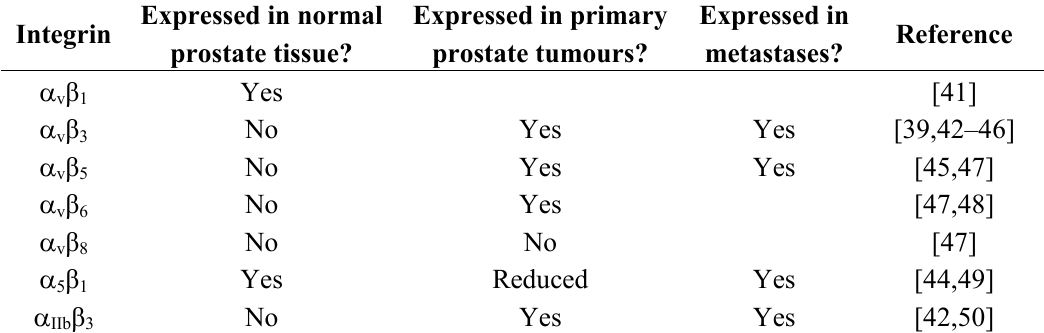
Table 2. Summary of RGD-binding integrin expression observed in prostate adenocarcinoma. Expressed in normal Expressed in primary Expressed in Integrin prostate tissue? prostate tumours? metastases?